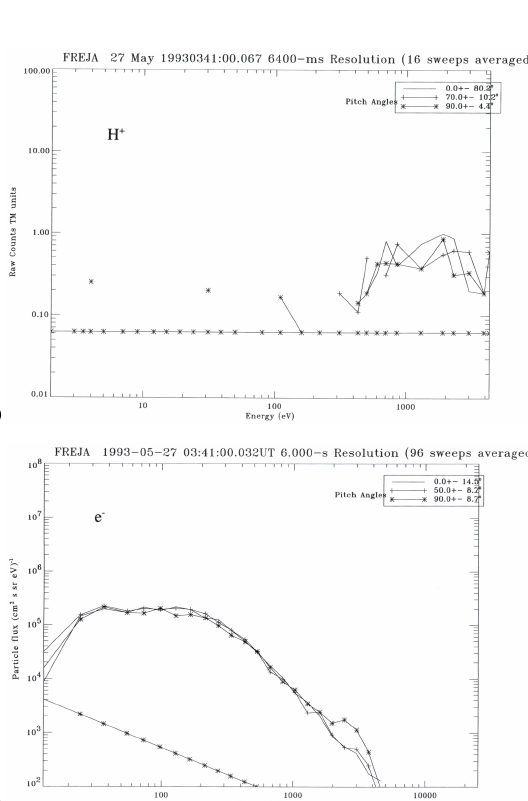
Fig.18. Full-pass CSP showing in- creasing H + energy starting at about 03:41UT. In the same period the en- ergies of the precipitating electrons in- crease strongly.